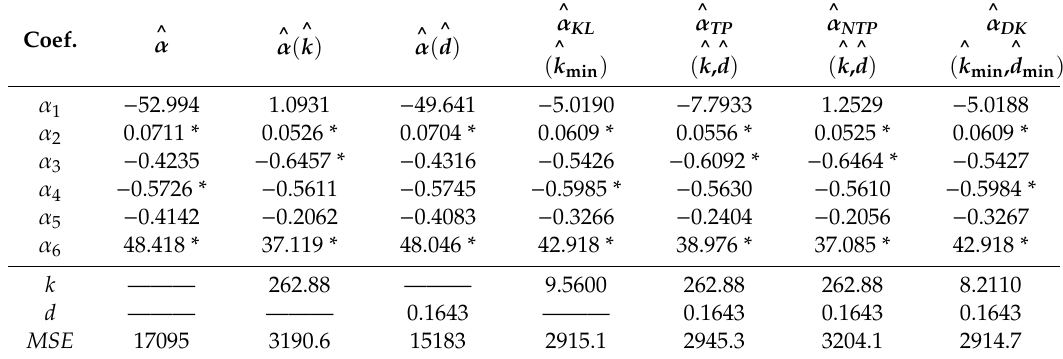
Table 6. The results of regression coe ffi cients and the corresponding MSE values.